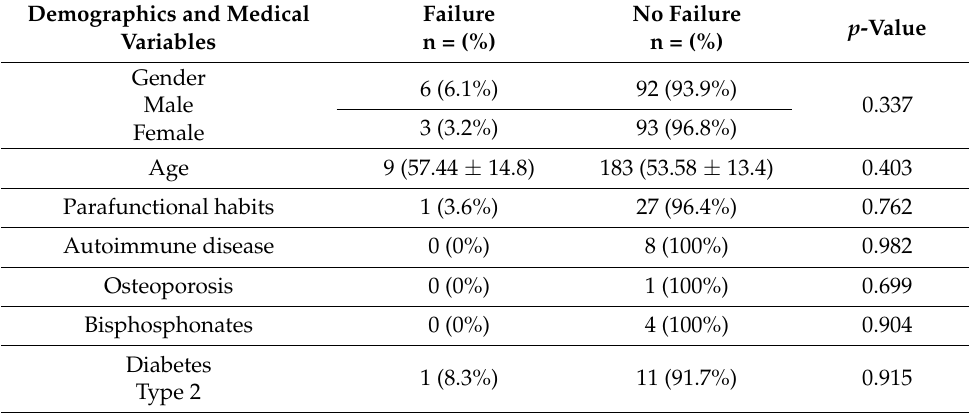
Table 5. Association between medical characteristics and implant